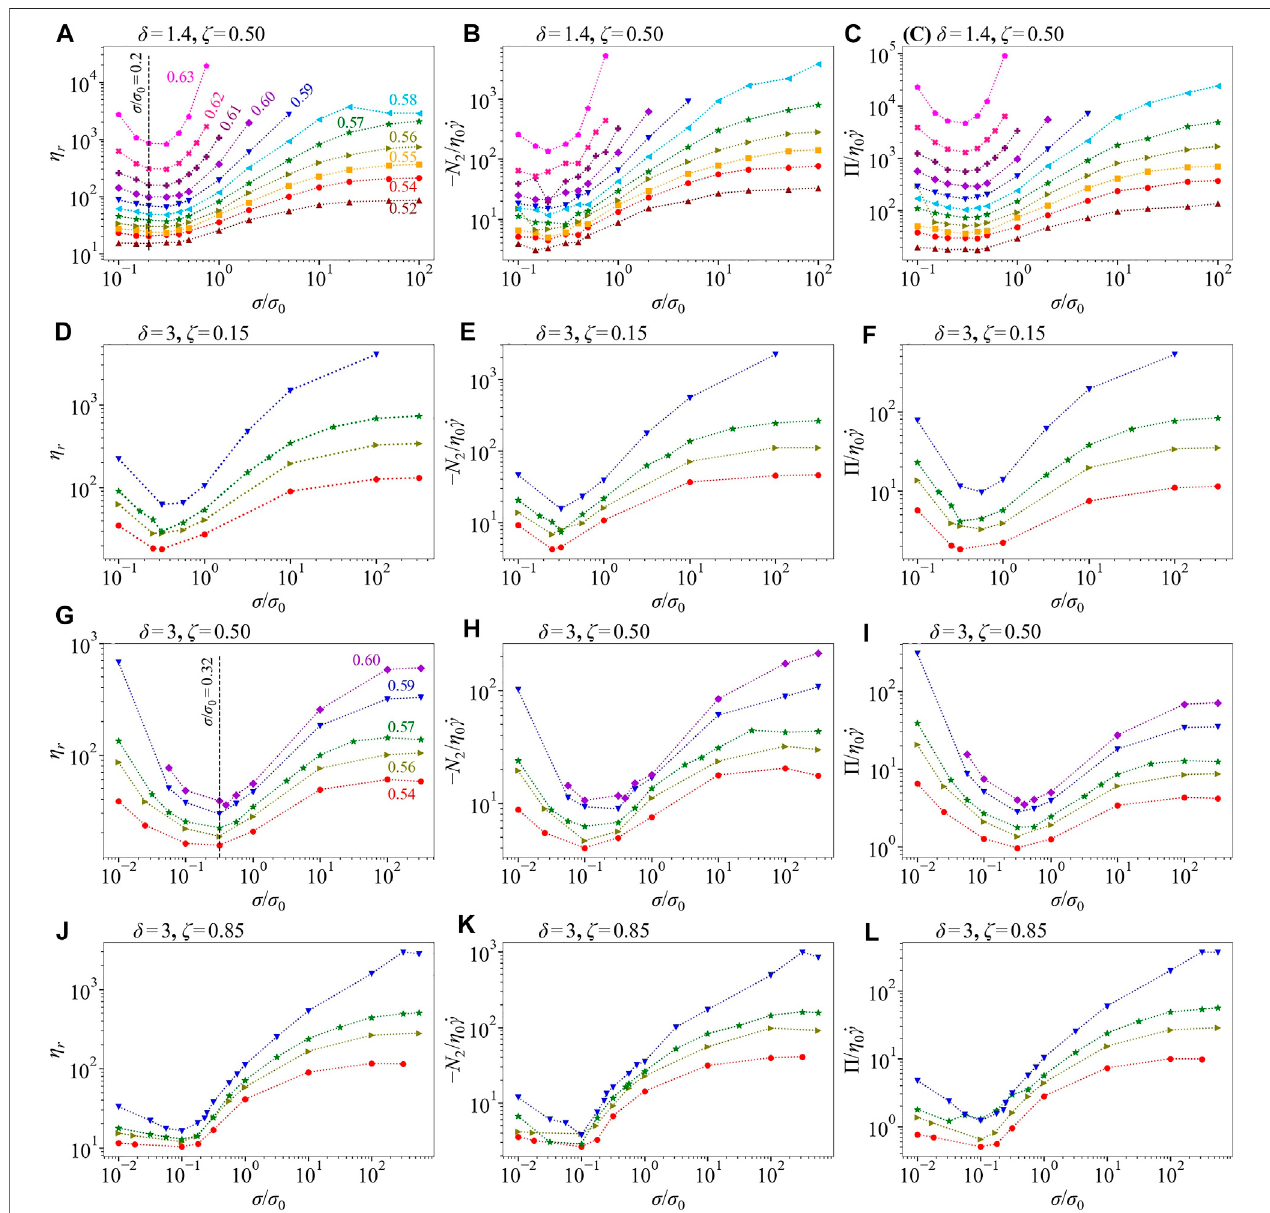
FIGURE1| Rheologyofsimulatedsuspensionsasafunction ofdimensionlessshear stress.Row1:Nearlymonodispersesuspensions, δ =1.4and ζ =0.50;rows 2 – 4:bidispersesuspensions.Row2: δ =3and ζ =0.15; row3: δ =3and ζ =0.50; row4: δ =3and ζ =0.85 (A)(D) (G) (J) : relative viscosity η r (B)(E) (H) (K) :thesecond normalstressdifferenceplottedas N 2 / η 0 _ γ (C)(F)(I) (L) :particle pressureplottedas Π / η 0 _ γ .Datain (A – C) arefrom theworkofSinghetal.[15].LegendsofpanelsAand Gapplyto (A – C) andto (D – L) ,respectively.Forthescalinganalysis,wedonotconsidershearthinningdata,and thusconsiderdatatotherightofthedashed lines shown in panels A and G as